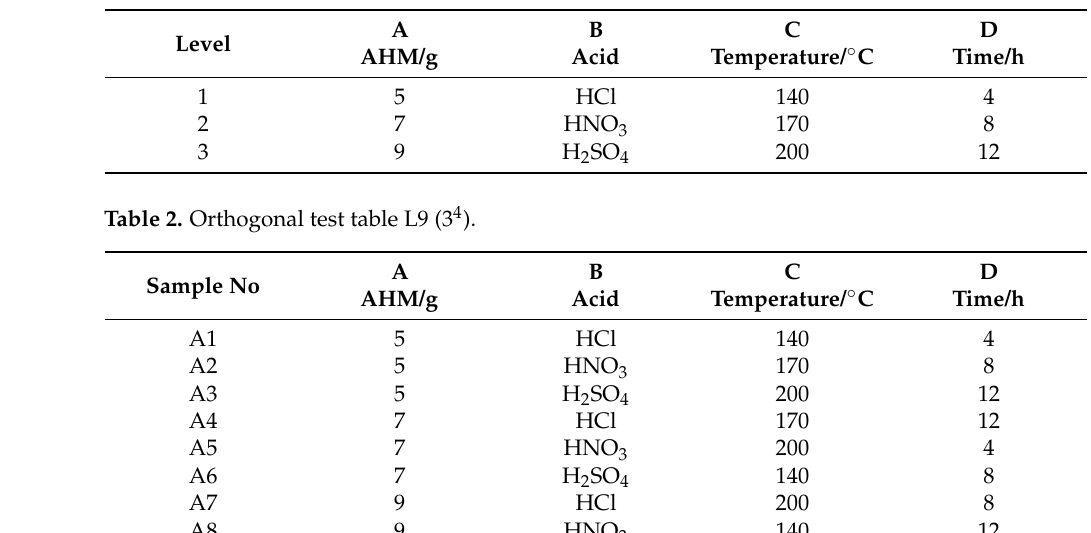
Table 1. Level table of orthogonal factors.